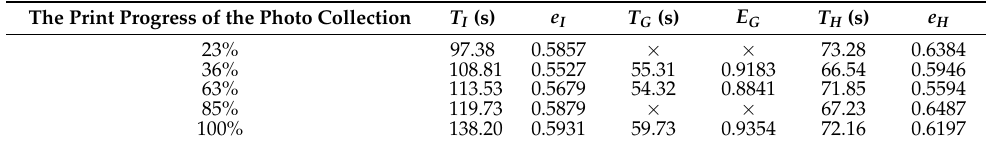
Table 4. Comparison of efficiency and accuracy of three SFM